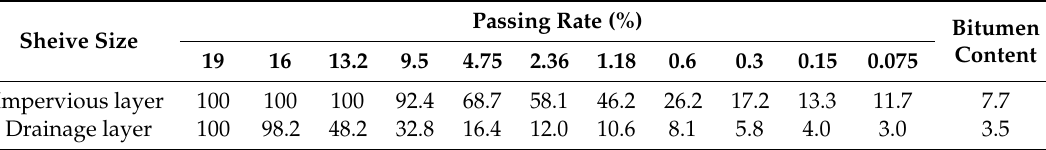
Figure 1. Cross section of Zhanghewan asphalt concrete facing. Table 1. Asphalt concrete mix ratio of the Zhanghewan